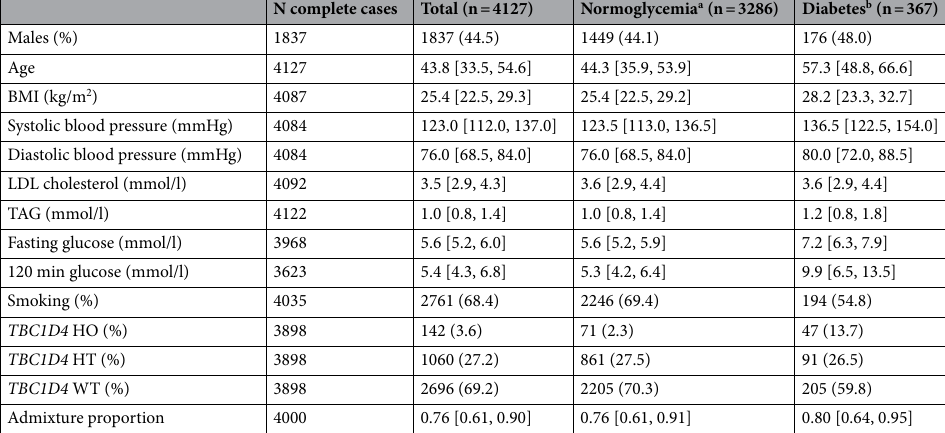
Table 1. Baseline characteristics. Data are median [interquartile range] and n (%). a 474 participants with missing OGTT data excluded. b Diabetes is both screen-detected and self-reported.